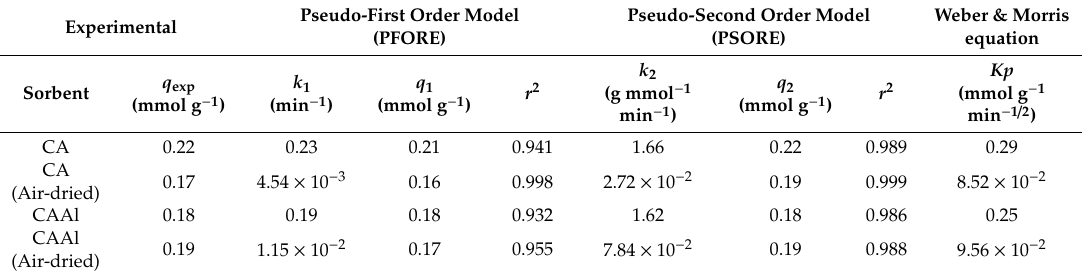
Table 4. Kinetic parameters of CA and CAAl materials.